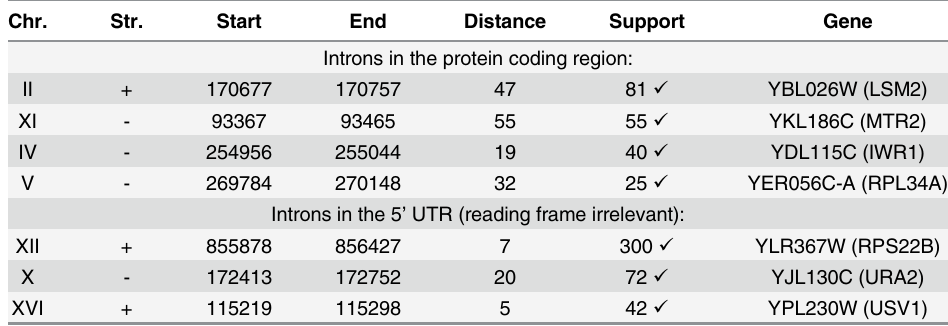
Table 5. Alternative 3 ’ splice sites with potential to disrupt the reading frame. Chr. Str. Start End Distance Introns in the protein coding region: